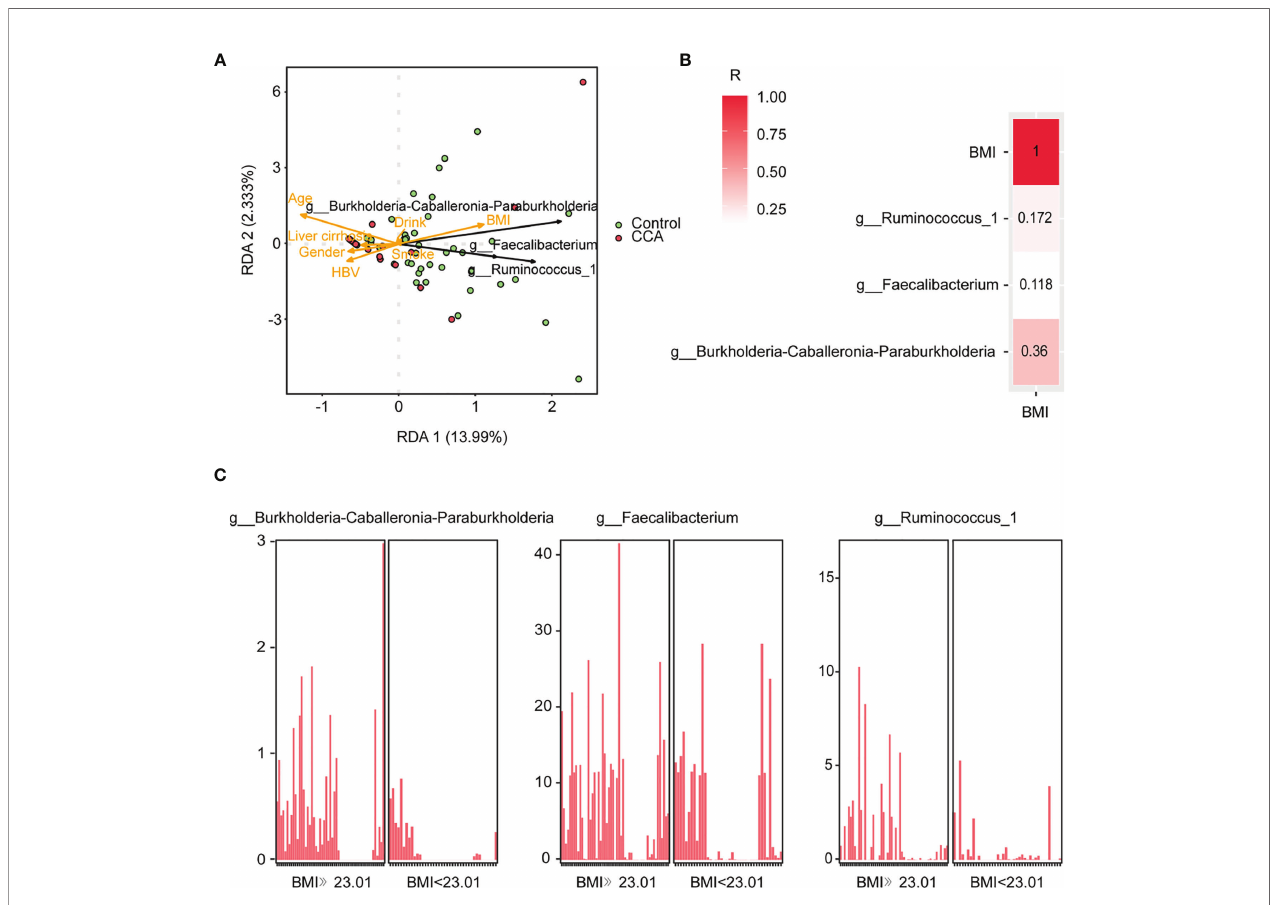
FIGURE 3 | The correlation of genera and clinical variables in control and cholangiocarcinoma (CCA). (A) Redundancy analysis of the three genera and clinical variables. (B) The correlation between body mass index (BMI) and microbial markers. The higher value indicates stronger correlation. (C) Abundance of g_Burkholderia-Caballeronia-Paraburkholderia, g_Faecalibacterium, and g_Ruminococcus_1 in individuals with different